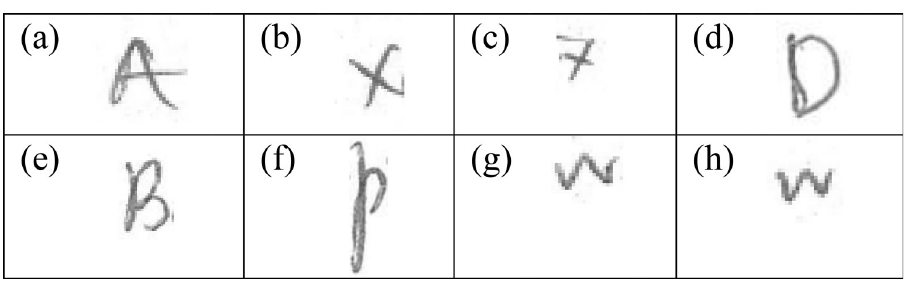
Fig 2. Characteristic handwritten allographic features from writers from Islamic religious schools.